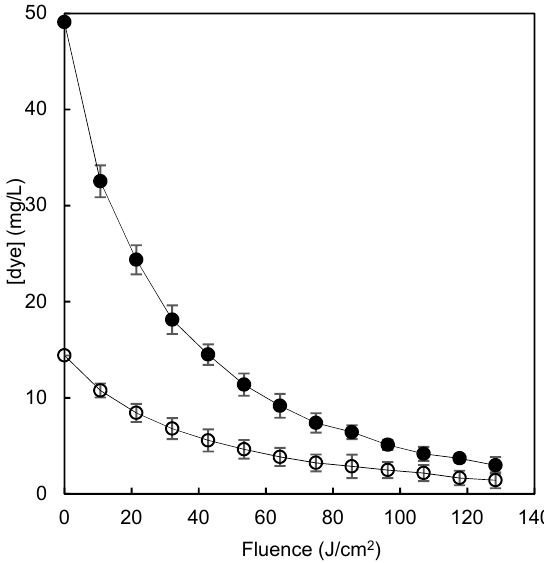
Figure 9. The degradation of Direct blue 78 by a pulsed light / H 2 O 2 advanced oxidation process in model wastewater after chitosan-NaOH (o) or β -CDs-EPI ( ● ) polymer adsorption.